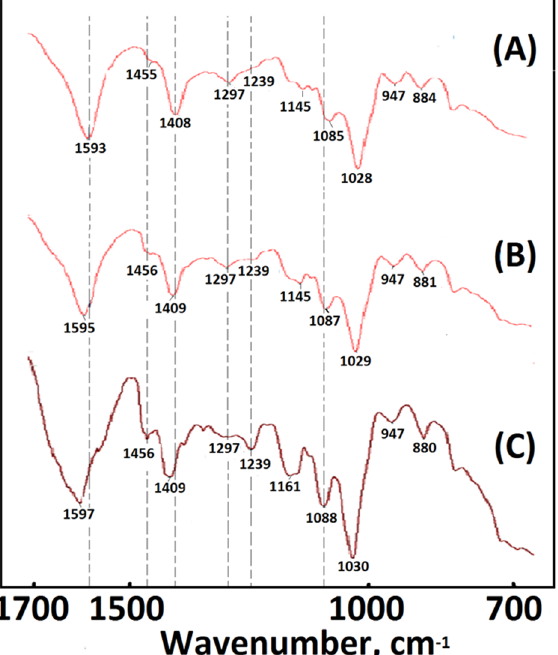
Figure 3. FTIR spectra of the samples: ( A ) PCFM1N, ( B ) PCFM2N, and ( C ) PCFM3N.